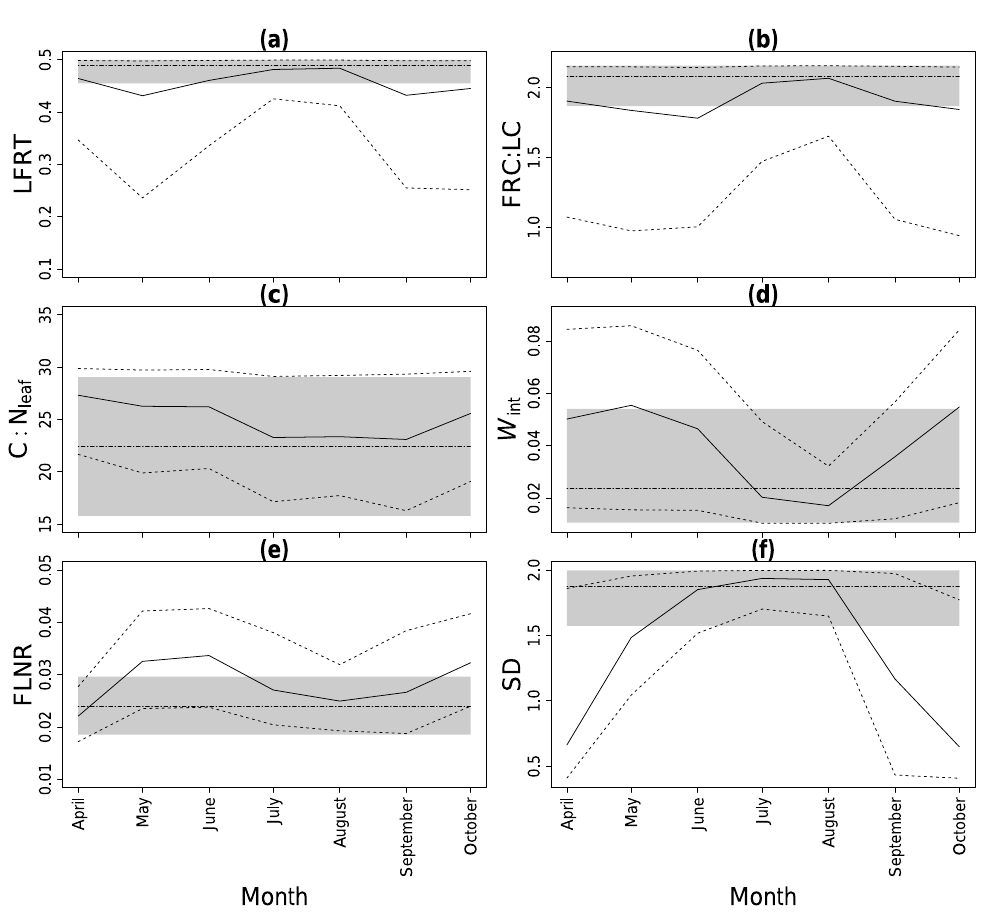
Figure 2. Median (solid lines) and 95% credible intervals (dashed lines) of the posterior distributions of each calibrated Biome-BGC parameter obtained from Experiment 2 for each month during the growing season of 2009. The grey shade and dotted–dashed line represent median and 95% credible intervals obtained for Experiment 1. The range of the y axis represents the prior uncertainty in Biome-BGC parameters. Information about the Biome-BGC parameters is given in Table 1. SD is the effective soil rooting